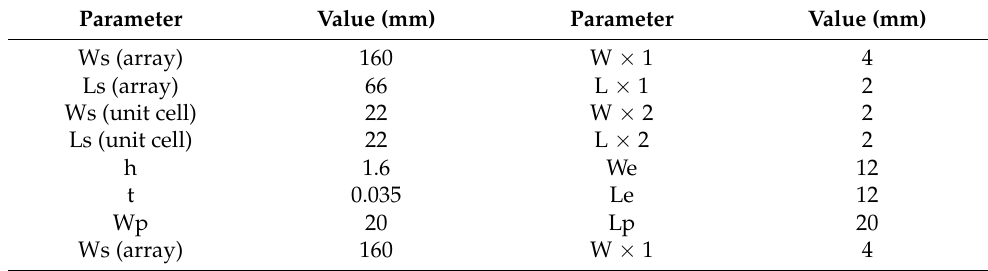
Table 2. Optimum parameters for the slotted square ring (SSR) of the FSS reflector. Parameter Value